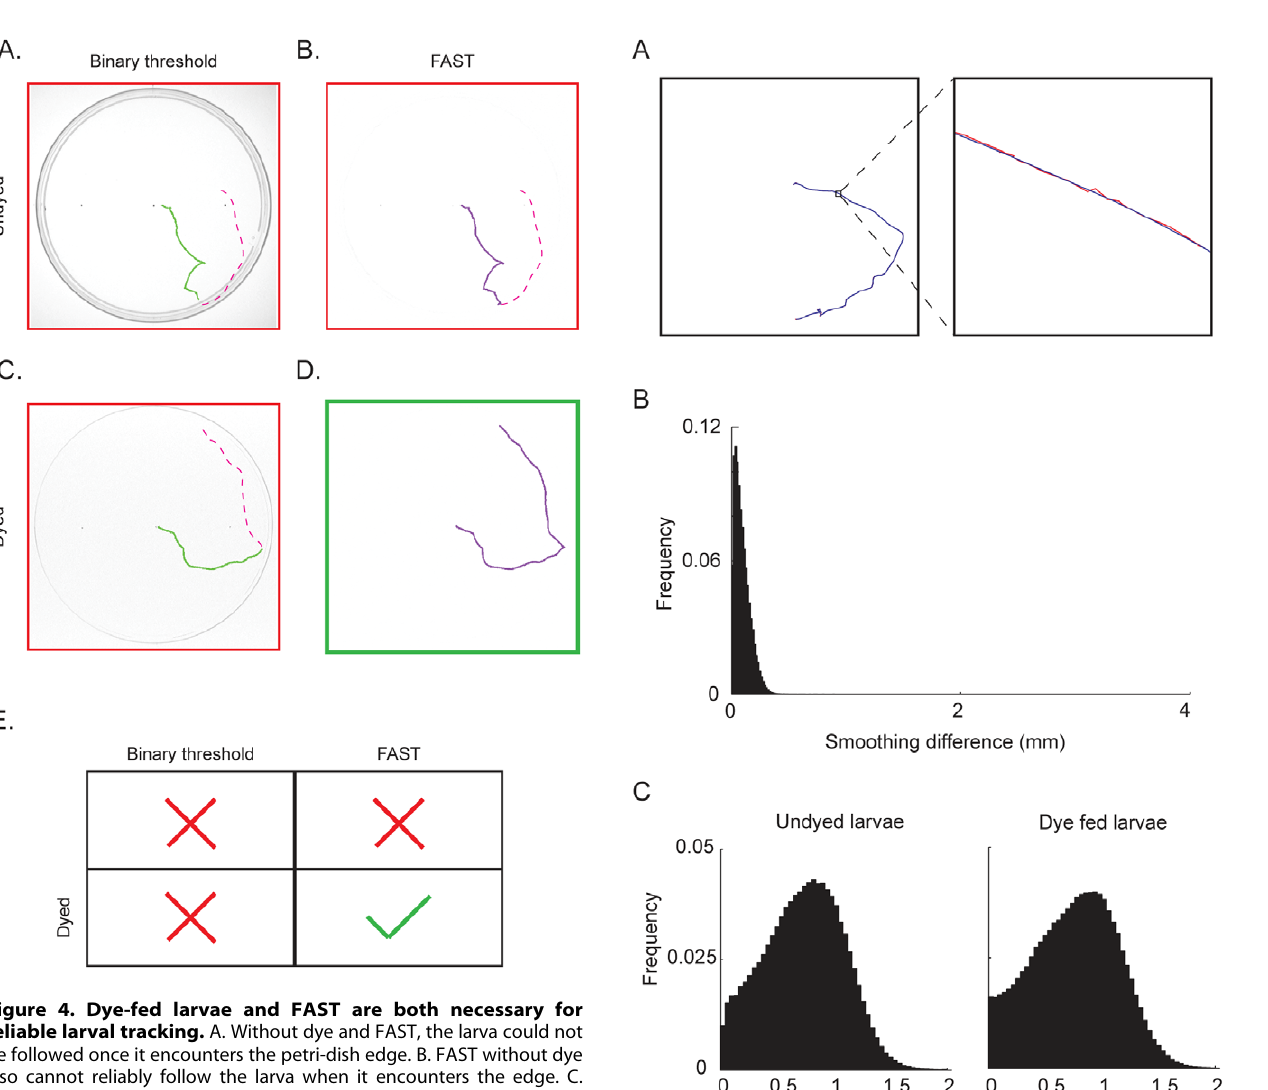
(Figure 5c). There was almost no difference (0.02 mm/s) between the speed of dyed and undyed larvae. (mean dyed speed = 0.76 mm/s, 100 larvae; mean undyed speed =0.74 mm/ s, 100 larvae). Our method is designed to track single animals as